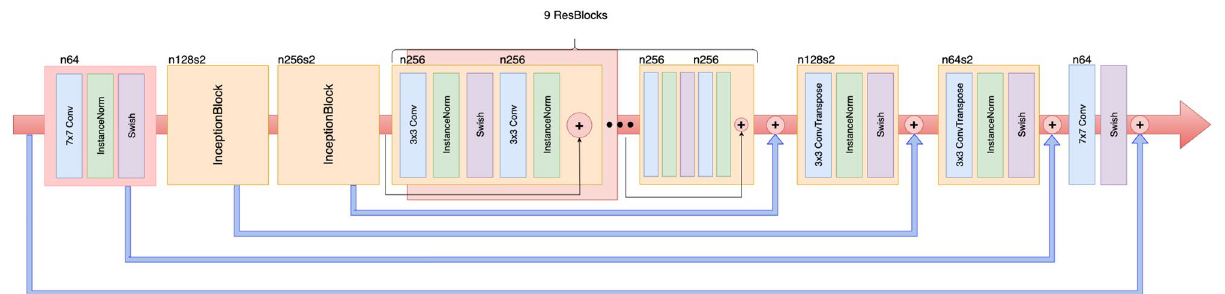
Figure 2. Generator architecture. n denotes the number of convolutional kernels, and s denotes stride. The default stride is 1, i.e., n64s2 denotes the convolution layer of 64 channels with stride inception blocks with stride two, nine residual blocks and two transposed convolution blocks. Each residual block consisted of a convolution layer, an instance normalization layer, and Swish activation 32,33 . The inception block, a collection of convolution layers of different sizes, such as the 1 × 1 convolution layer, 5 × 5 convolution layer, 9 × 9 convolution layer and 13 × 13 convolution layer, could capture detailed and brief characters without changing the image size. To concatenate different convolution layers in the inception block with different priori- ties, as shown in Fig. 3, we multiply different weights by 1, 5, 9 and 13. For discriminator D, shown in Fig. 4, inspired by Ledig et al. 34 , we followed architectural guidelines and dropped the last full connection from the last layer to the convolution layer with the input patch image, which aims to classify whether overlapping image patches were real or generated. Such a patch-level discriminator architecture had fewer parameters than a full-image discriminator and could work on arbitrarily sized images in a fully convolutional method. Loss functions. Our goal in this study is to define a deep neural network that finds a suitable mapping func- tion that minimizes the loss functions. Let x ∈ X and X was CBCT that was an input image. Let y ∈ Y and Y be FBCT, which was the ground truth image. In general, we can define the mapping function as Eq. (1)